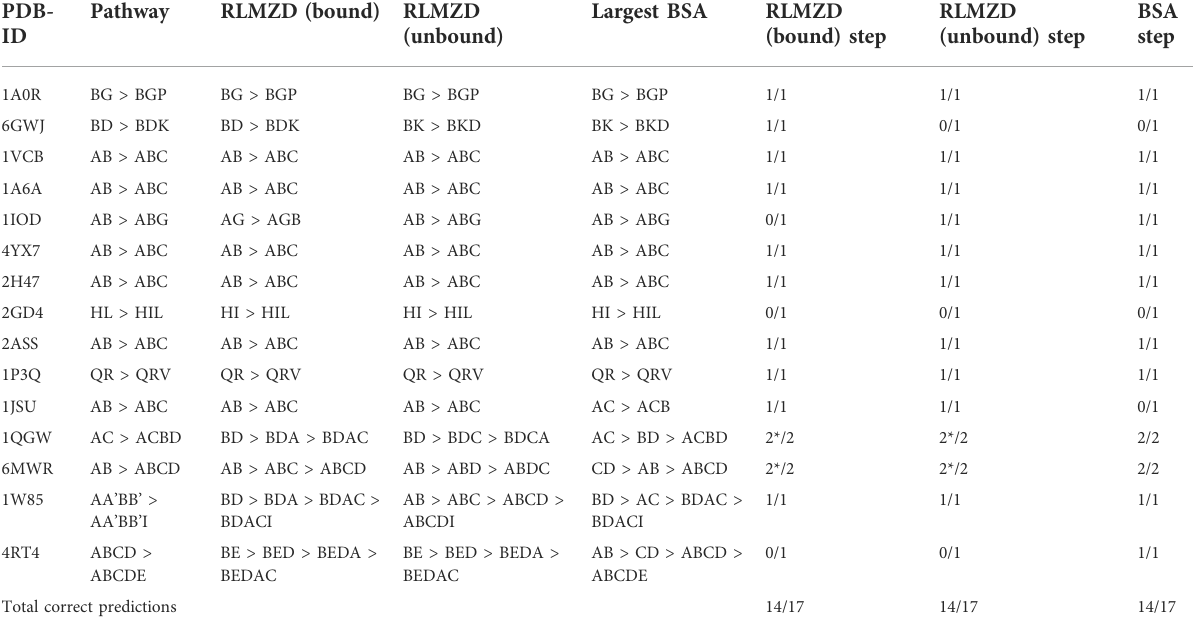
TABLE 4 Docking order prediction